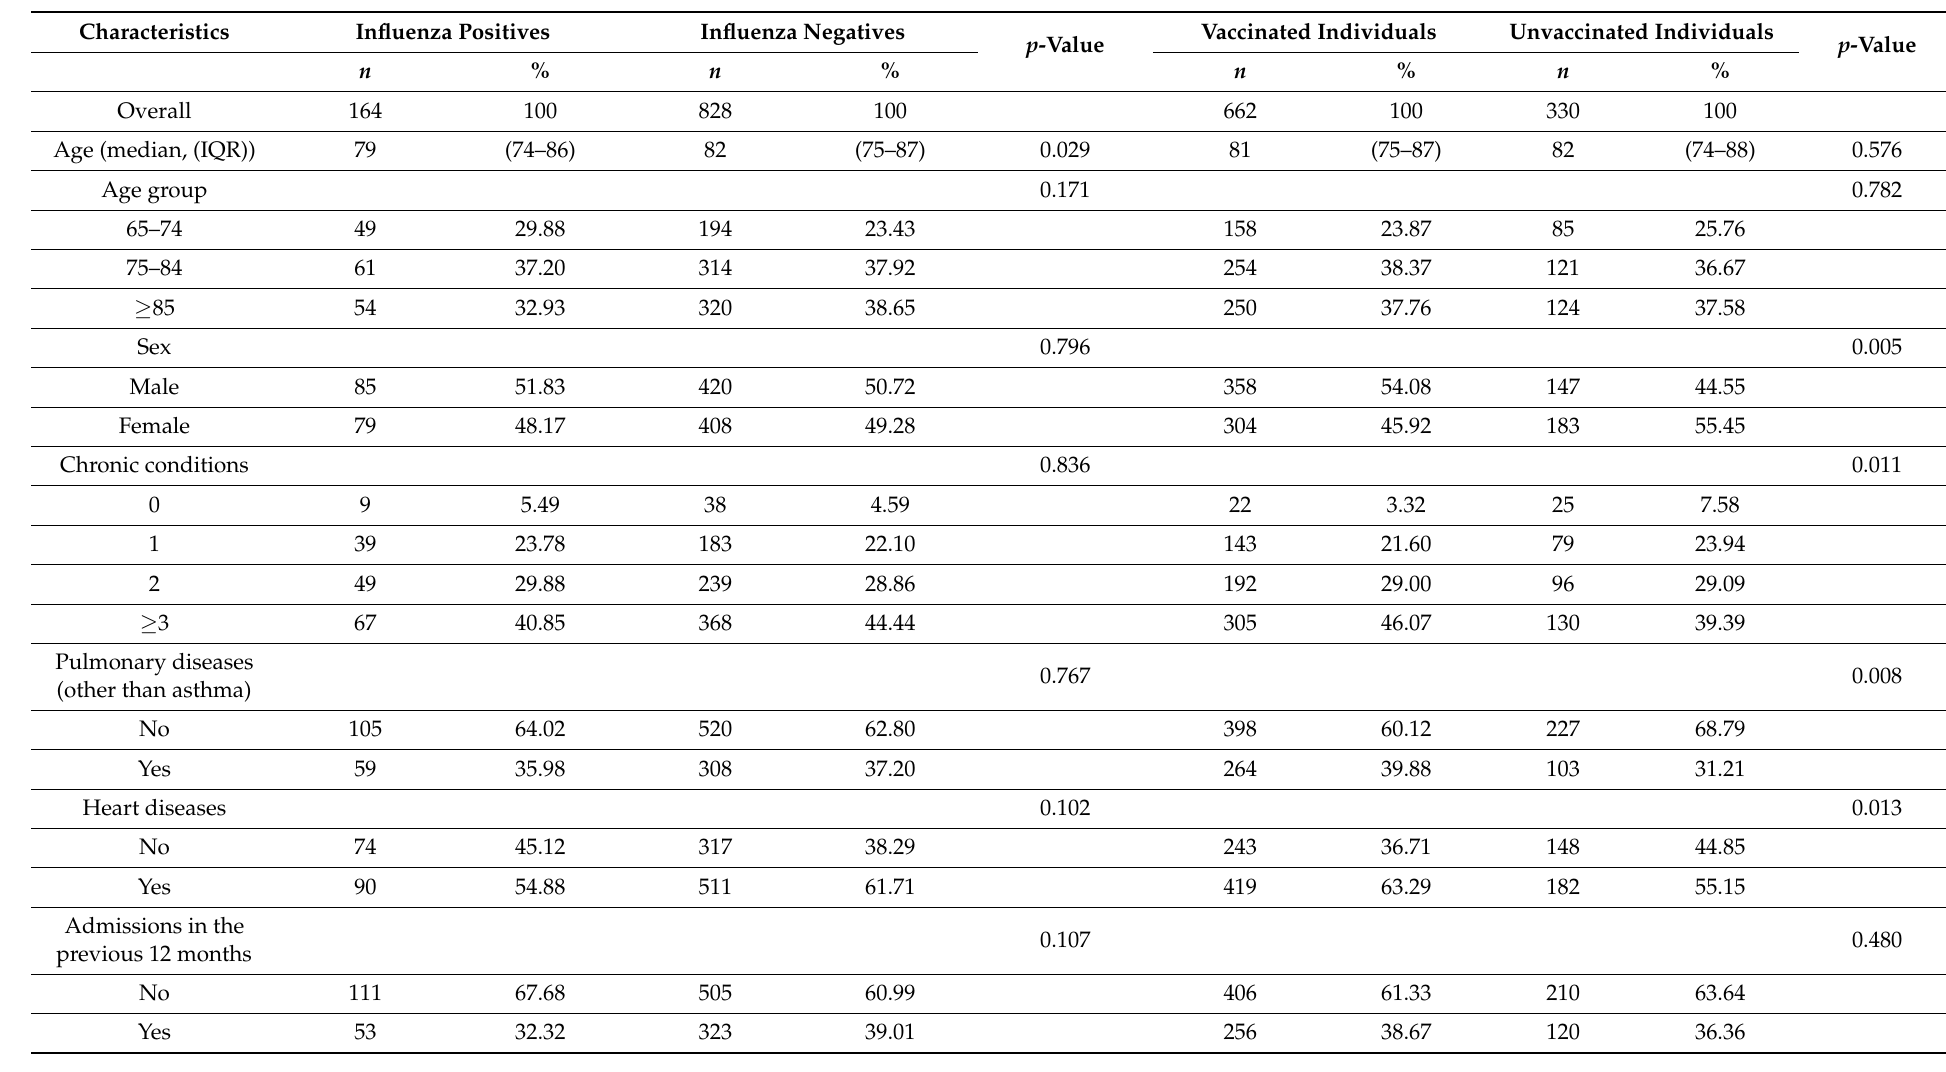
Table 1. Characteristics of included admissions in the Valencia Hospital Network for the Study of Influenza (VAHNSI) in the 2018/2019 season.